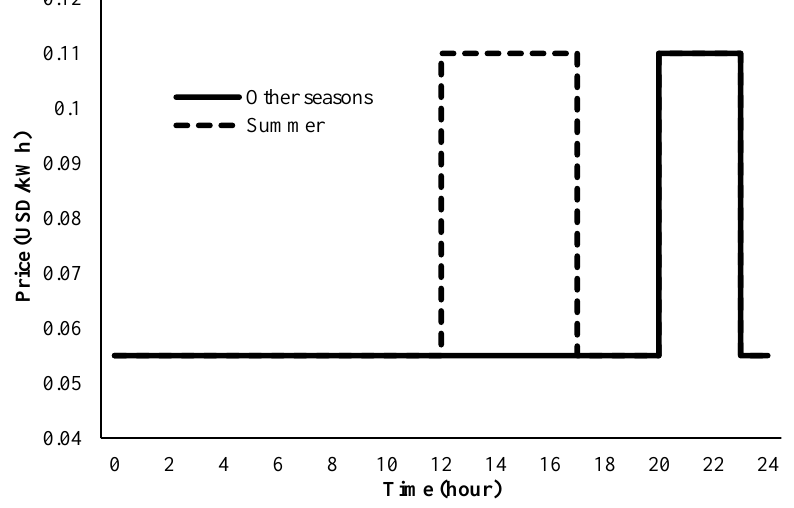
Figure 3. Proposed purchasing energy price from the PV system in Case I.